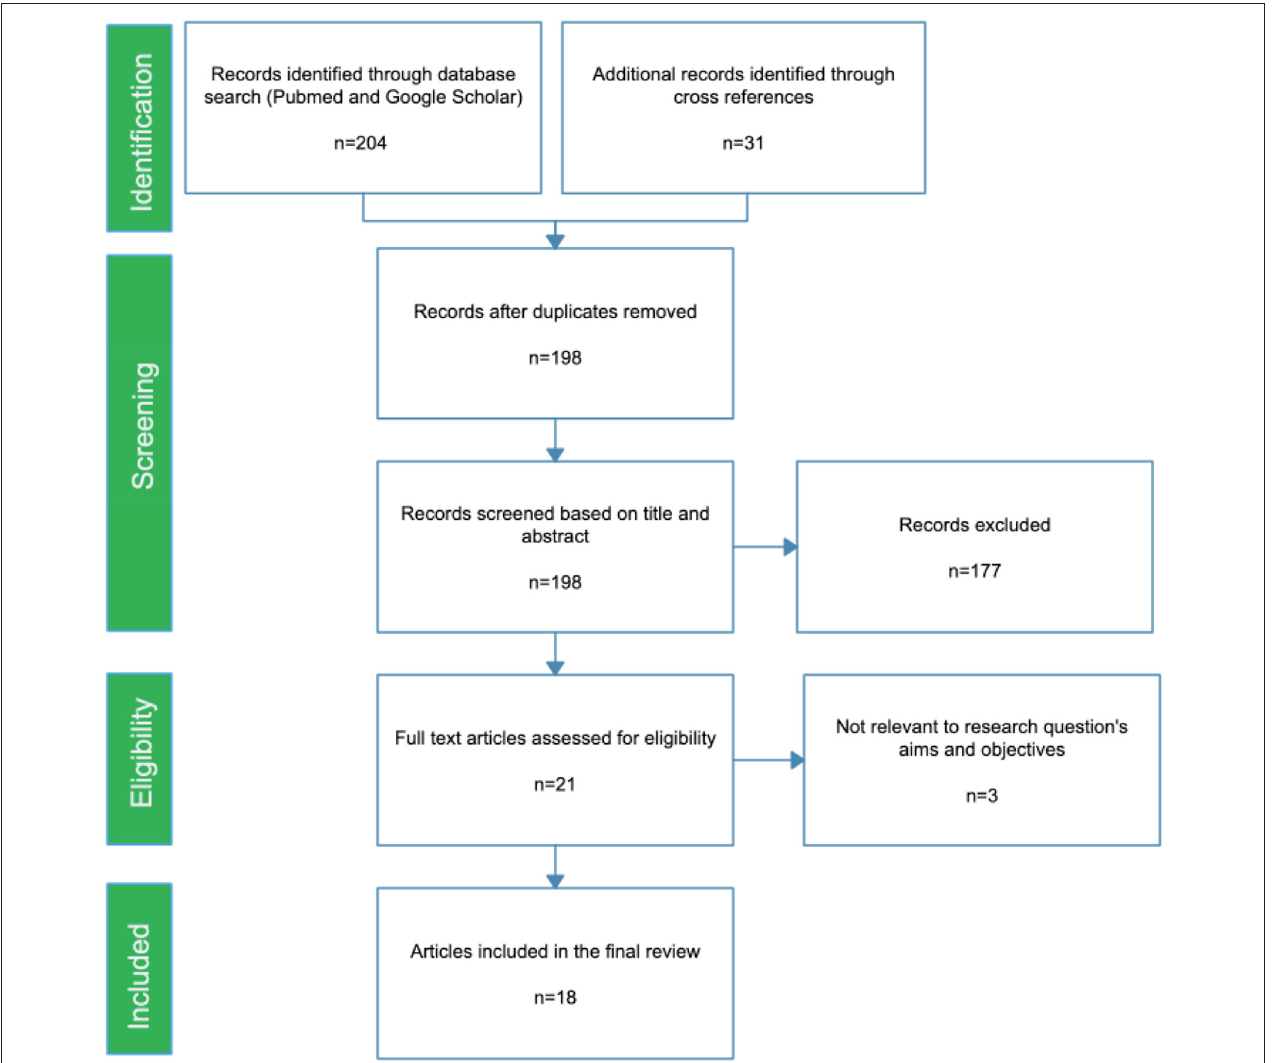
FIGURE 1 | PRISMA flow diagram of the scoping